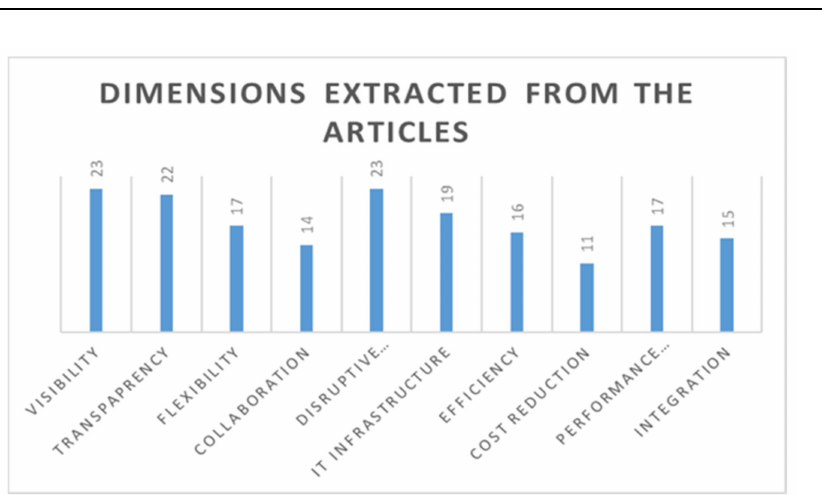
Figure 9. Dimensions extracted from the articles according to the number of